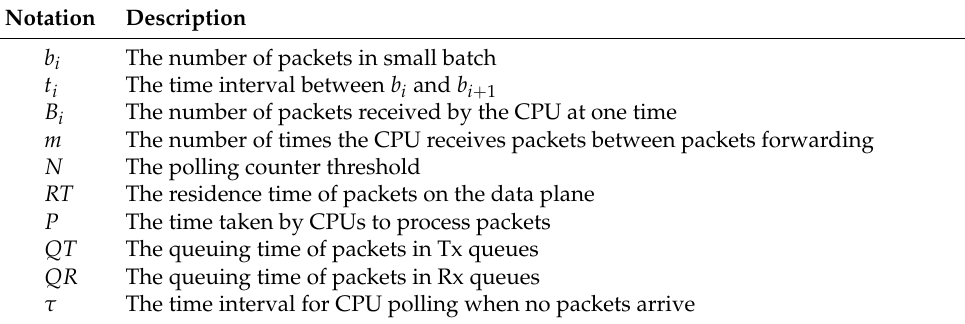
Table 2. Summary of Notations.